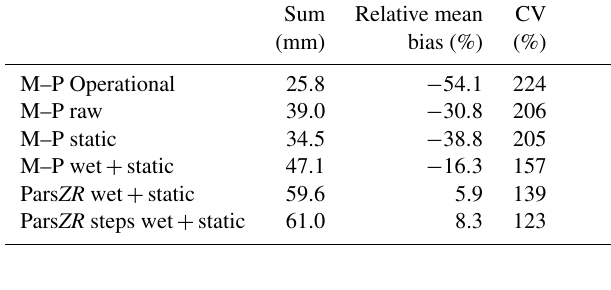
Table 3. Rainfall sum (mm) from the radar, together with relative mean bias (%) and coefficient of variation (CV) (%) of 10min rain- fall intensities from the rain gauge and the radar for different correc- tion combinations. Here, operational means the operational Doppler clutter-corrected data, raw means the uncorrected data, static the static-clutter-corrected data and wet the wet-radome-corrected data. M–P is the rain rate derived using the Marshall–Palmer equation. Pars means the rain rate derived using the Z – R relation found from all data of the Parsivel ® . Finally, Pars steps is the same, but for all episodes of the event, the derived Z – R values are used.